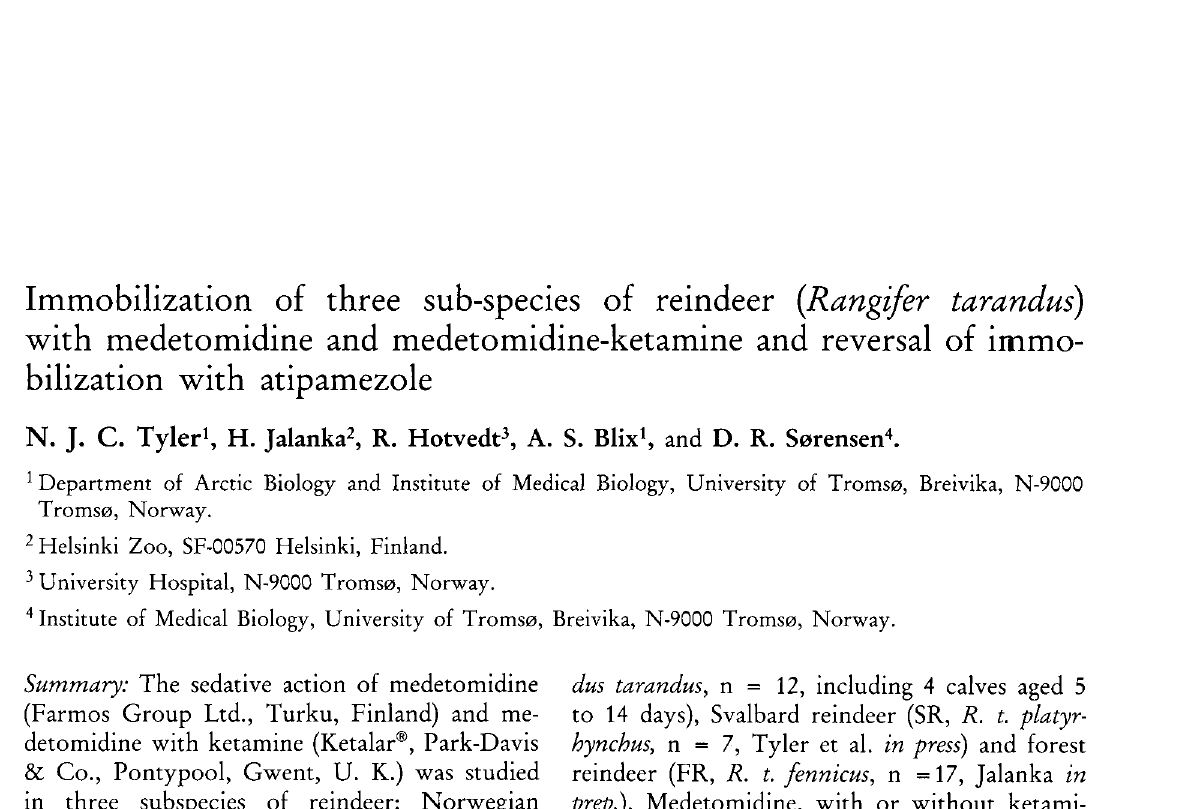
Table 1. Doses (/xg/kg live weight) of medetomidine, medetomidine-ketamine and atipamezole in Nor wegian reindeer aged > 2 yrs (NR), Svalbard reindeer (SR) and wild forest reindeer (FR) (number of